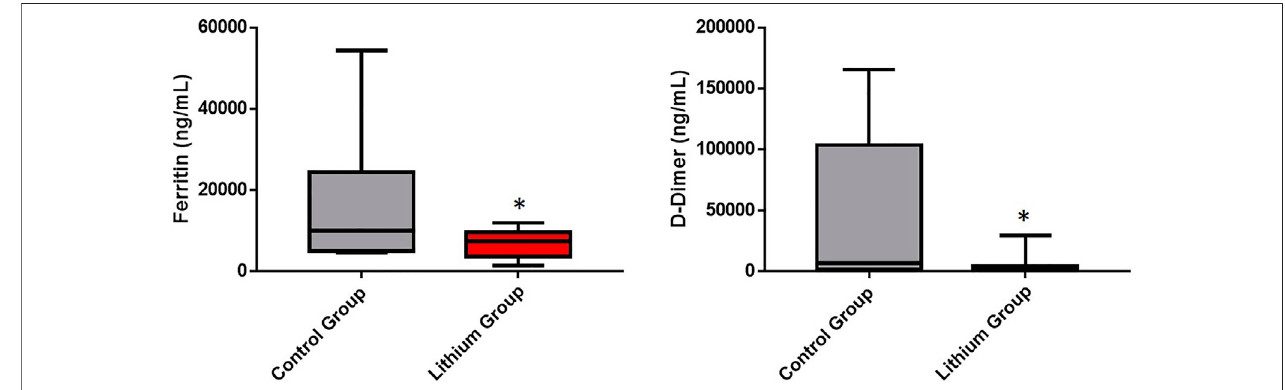
FIGURE 6 | Reduction of ferritin and D-dimer levels in patients treated with lithium. The area under the curve of the ferritin and D-dimer levels of patients, control group and lithium group is quanti fi ed. Ferritin is an index that indicates the accumulation of iron and is associated with the in fl ammatoryactivity ofmacrophages. Lithium reducessigni fi cantlythelevelsofferritin( p < 0.05).COVID-19isusuallycomplicatedbycoagulopathy.D-dimerisamakerofthrombingenerationand fi brinolysisandthis constitutes arelevant prognostic index ofmortality fromthe infection. The D-dimer valueisassociated withthe severity ofpatients with COVID-19. Lithium reduces signi fi cantly D-dimer levels and the risk of coagulopathy and mortality ( p <